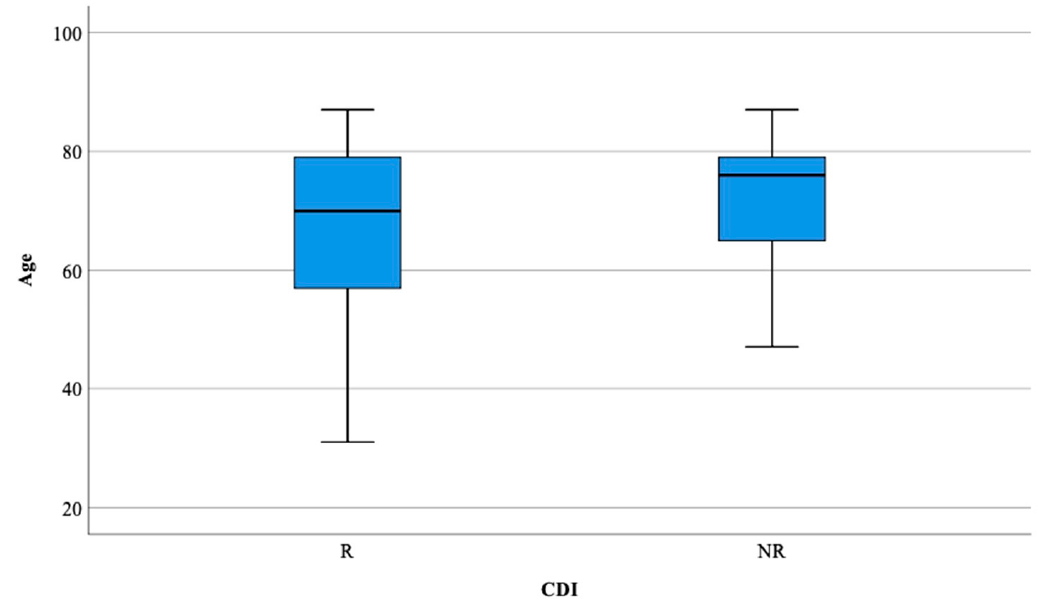
Figure 1. Distribution of the patients according to ages in both groups. R—recurrent; NR—non-recurrent. Table 1. Distribution of the patients according to the age groups.